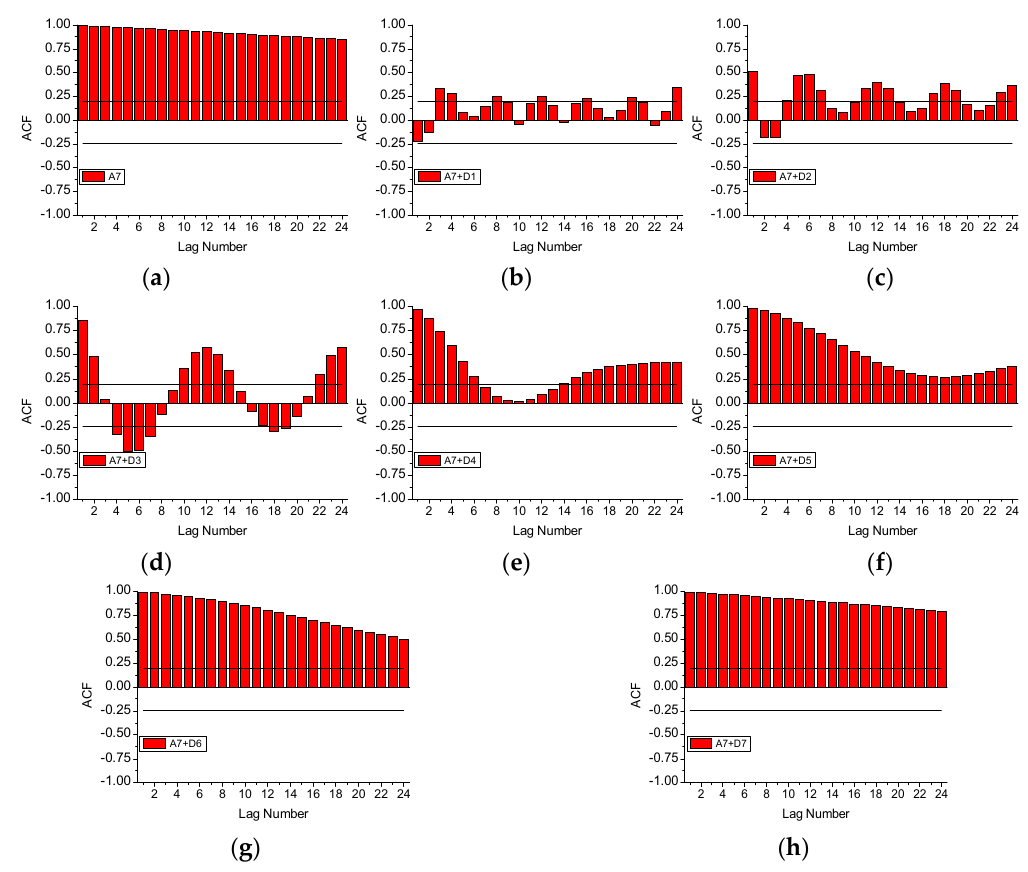
Figure 9. The correlograms of A7 and each detail component with A7 decomposing from the monthly streamflow series via DWT. The upper and lower solid lines represent the confidence intervals (95% confidence level). ( a ) A7; ( b ) A7+D1; ( c ) A7+D2; ( d ) A7+D3; ( e ) A7+D4; ( f ) A7+D5; ( g ) A7+D6; ( h ) A7+D7. Table 4. Slope β (computed by TSA), Lag-1 ACFs, Mann-Kendall values (three MK tests) and energy of monthly mean streamflow series: original data, detail components (D1–D7), approximations (A7) and a set of combinations of the details and their respective approximations. C 0 is the correlation coefficients between the decomposition combinations and the original series.